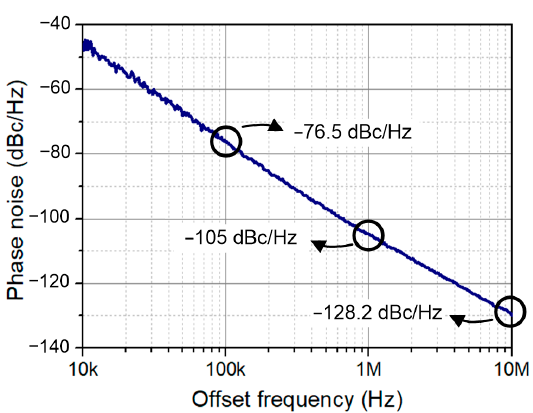
Figure 8. This figure is a measurement of phase noise at 24-GHz output frequency.